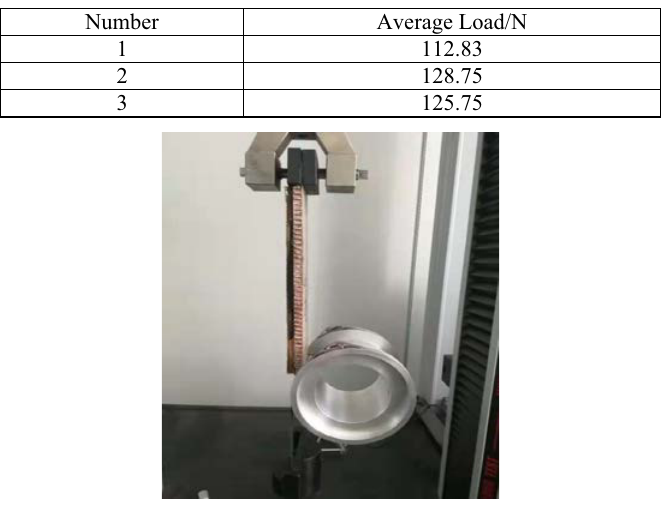
Fig. 9. Roller peeling sample